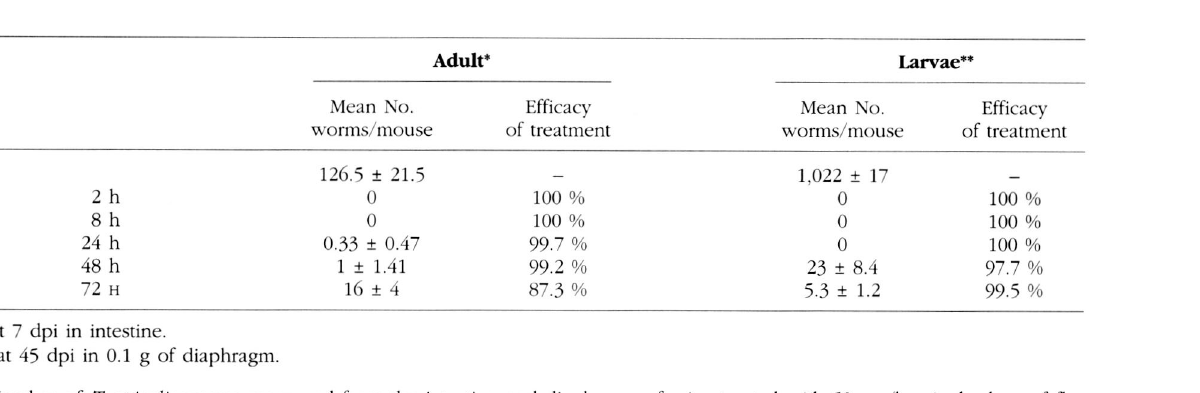
Table IV. - Number of T. spiralis worms recovered from the intestine and diaphragm of mice treated with 50 mg/kg single dose of flu bendazole at various time after infection.